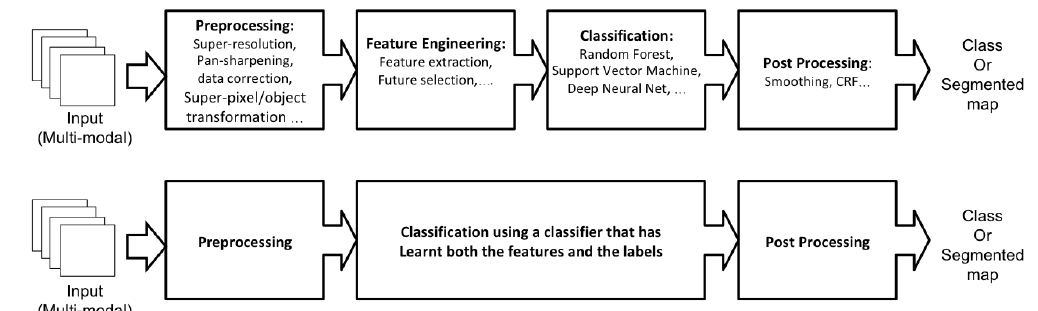
Figure 5. The machine learning classification frameworks. The upper one shows the common steps of the conventional approaches, and the lower one shows the modern end-to-end structure. In the end-to-end deep learning structure, the feature engineering is replaced with feature learning as a part of the classifier training